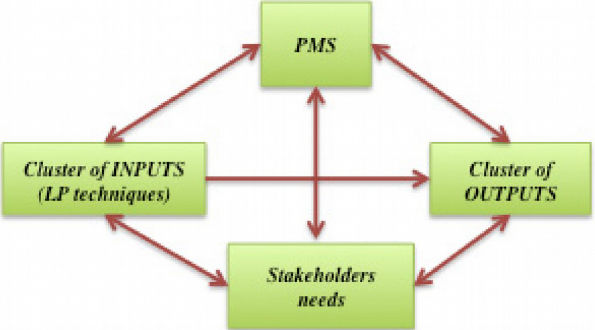
Figure 2. ANP-based network to measure the impact of LP on organisational